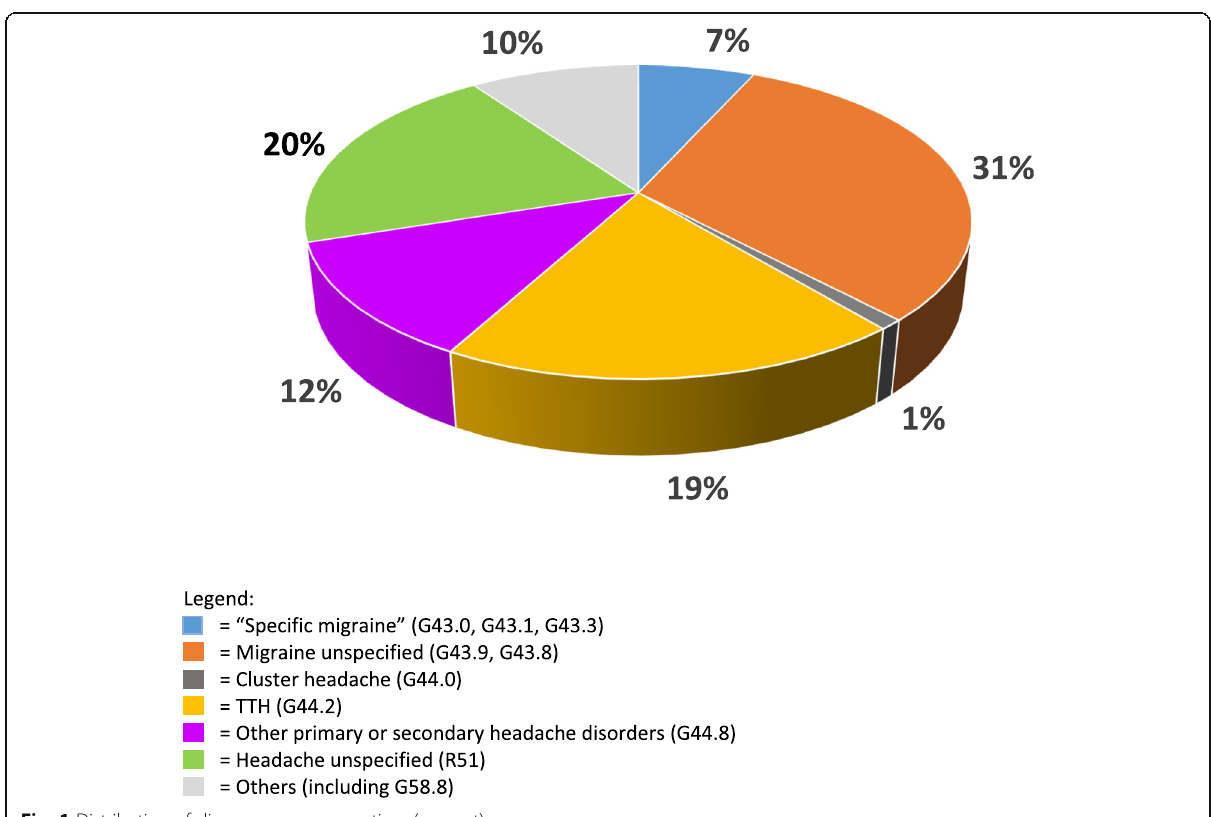
Fig. 1 Distribution of diagnoses across practices